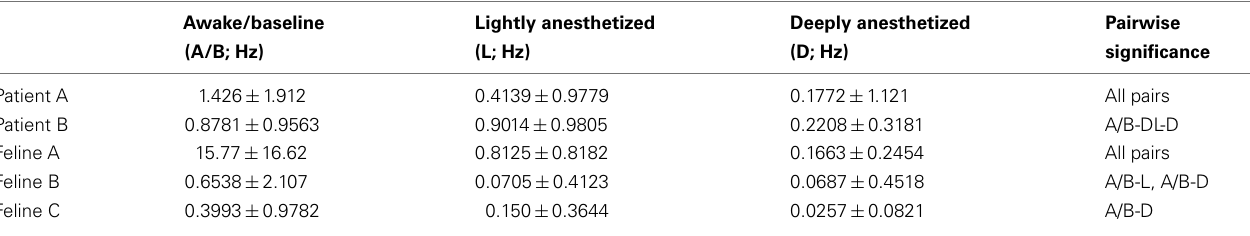
Table 2 |Average firing rate for a 30-s time window for all subjects across all electrodes ( N = 96; mean ± SD).